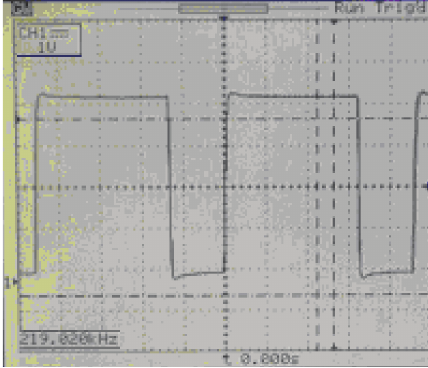
F 21: Frequency change for different stone samples, 2-plate capacitor.